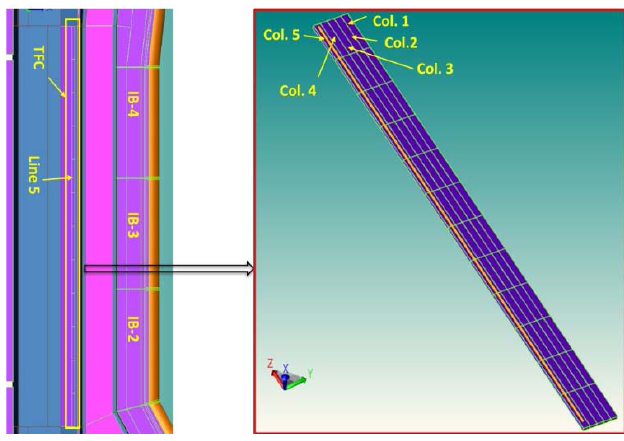
Figure 4. Tally cells for radiation loads on